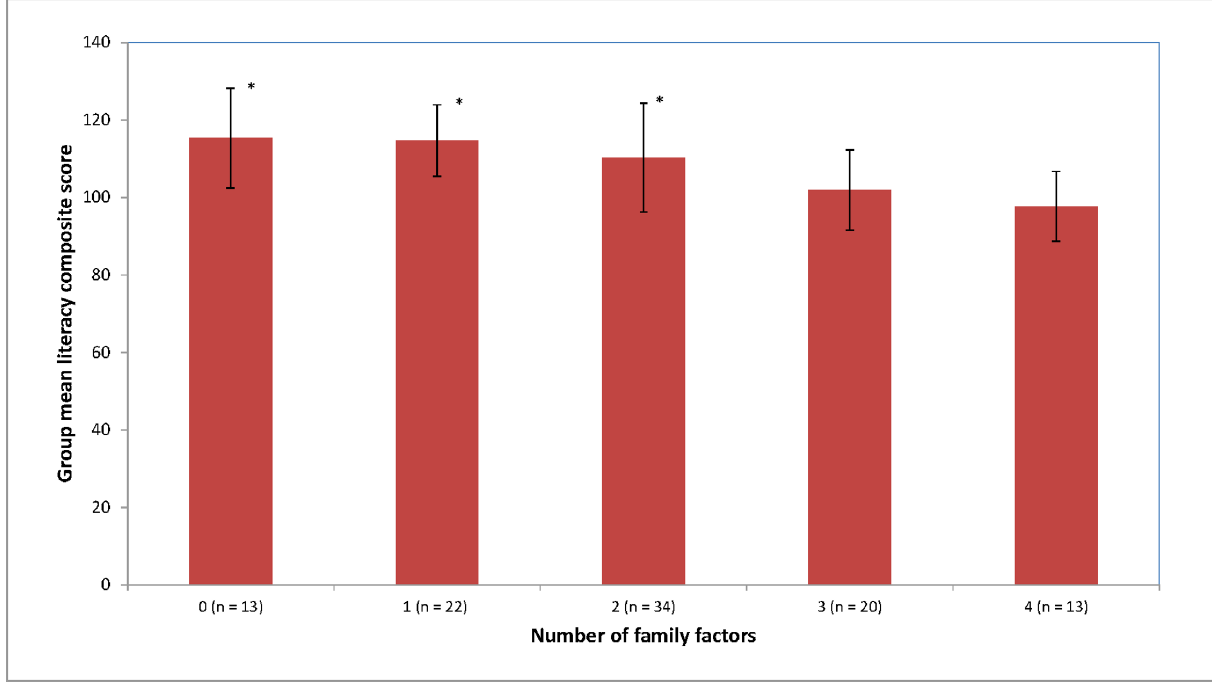
Figure 1. Literacy composite scores as a function of children’s number of potential familial risk factors. Risk factors were operationally defined here as: school SES, mother’s level of education, parents’ PA, parents’ PSE and family history of reading difficulty. Error bars denote standard deviations. *signifiactly different ( p , .05) to those with 3 or 4 family factors. NB: No child was found to have all 5 familial risk factors.